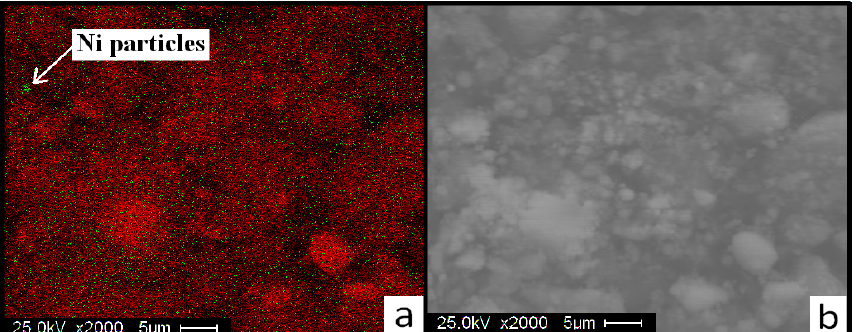
Figure 9. Scanning electron microscopy (SEM)/ energy dispersive X-rays (EDX) mapping ( a ) and image ( b ) of the 2LiNH 2 -nanoMgH 2 + 2 wt. % Ni. Red and green color (labeled) represents Mg and Ni, respectively.